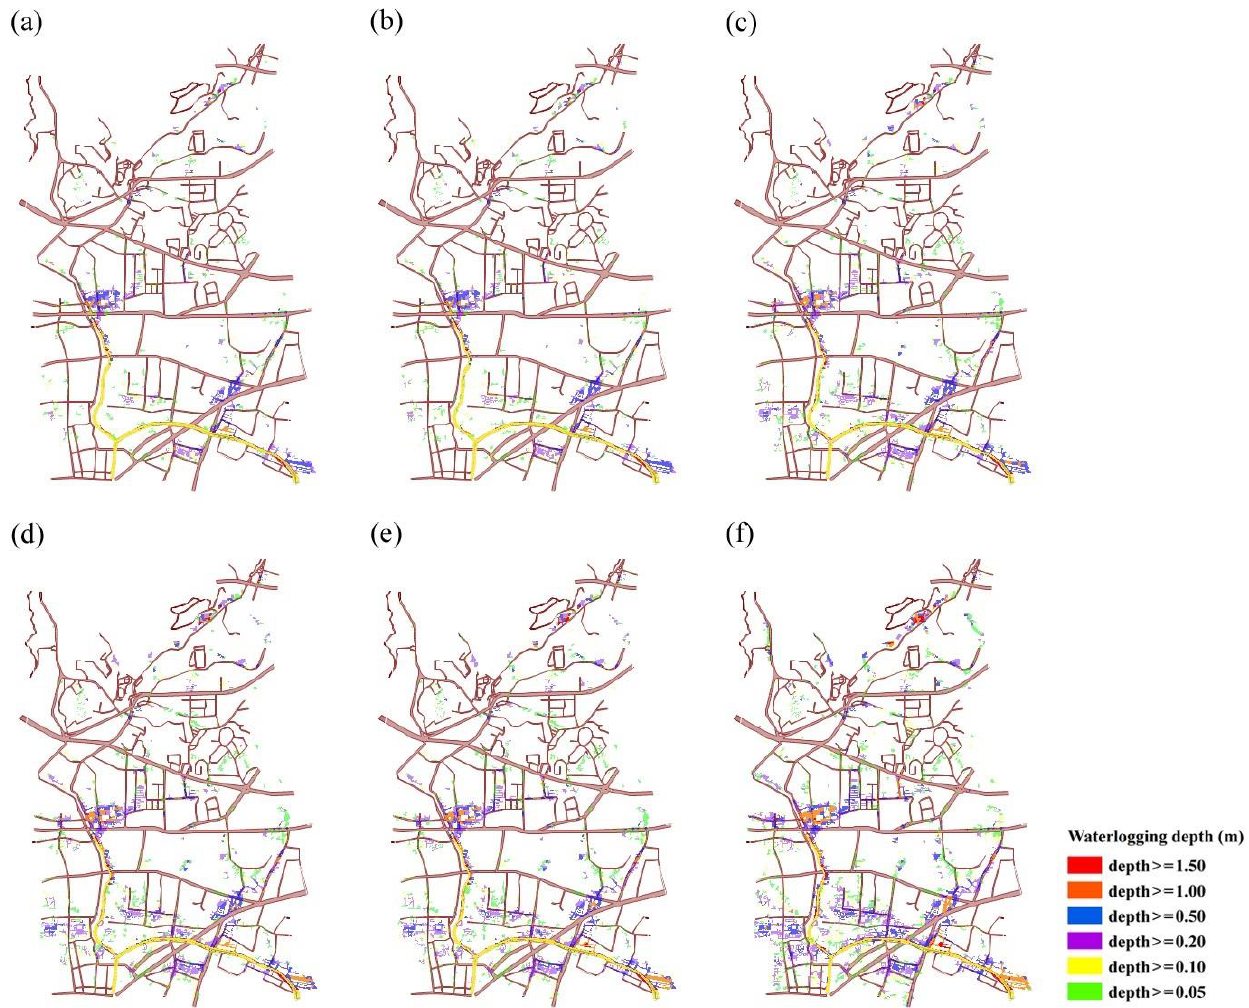
Figure 7. The spatial distribution of waterlogging depth. ( a ) 2a return period under RF period. ( b ) 2a return period under RCP4.5. ( c ) 2a return period under RCP8.5. ( d ) 20a return period under RF period. ( e ) 20a return period under RCP4.5. ( f ) 20a return period under RCP8.5.